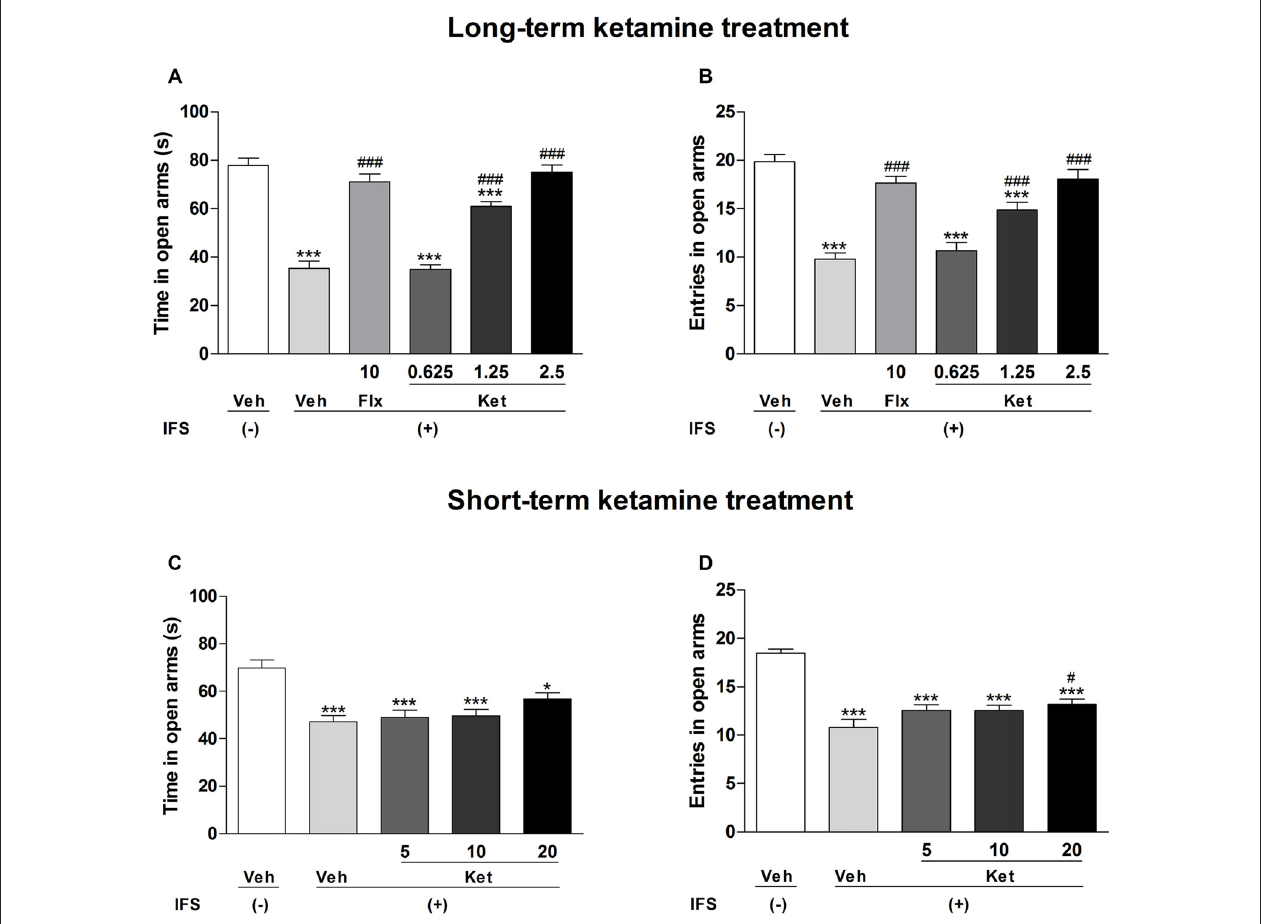
FIGURE 4 | The effects of ketamine on EPM test in IFS mice. (A,B) Exposure to IFS resulted in a decreased percentage of time spent in and entries into open arms, whereas long-term ketamine treatment alleviated the behavioral deficits. (C,D) Short-term ketamine administration did not diminish the decreased percentage of time spent in and entries into open arms except the dose of 20 mg/kg ketamine. Data are presented as mean ± SEM ( n = 15 in per group). ∗ P < 0.05, ∗∗∗ P < 0.001 compared with the Veh group; # P < 0.05, ### P < 0.001 compared with the IFS + Veh group.